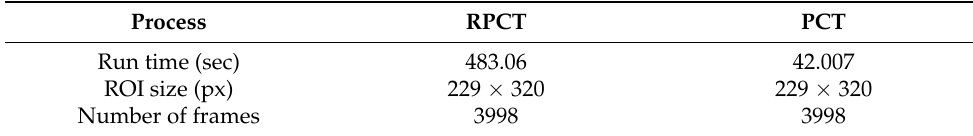
Table 2. Processing time of RPCT and PCT